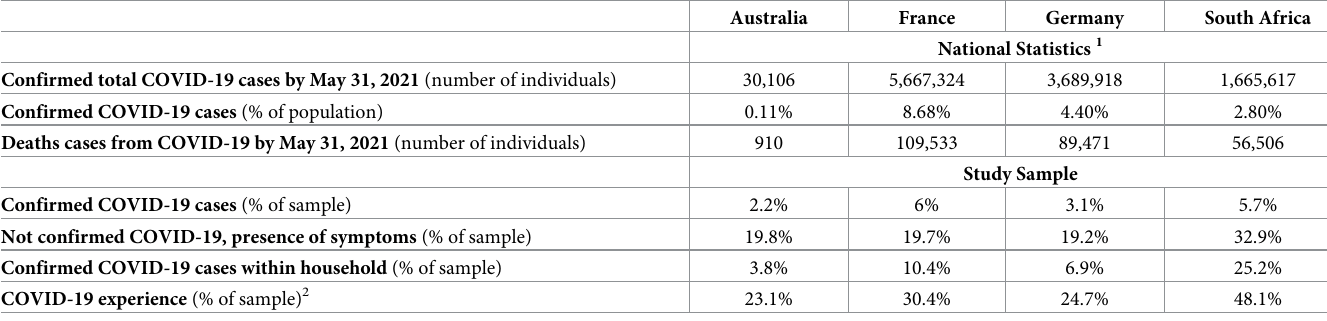
Table 2. National and study sample statistics of COVID-19 during the sample